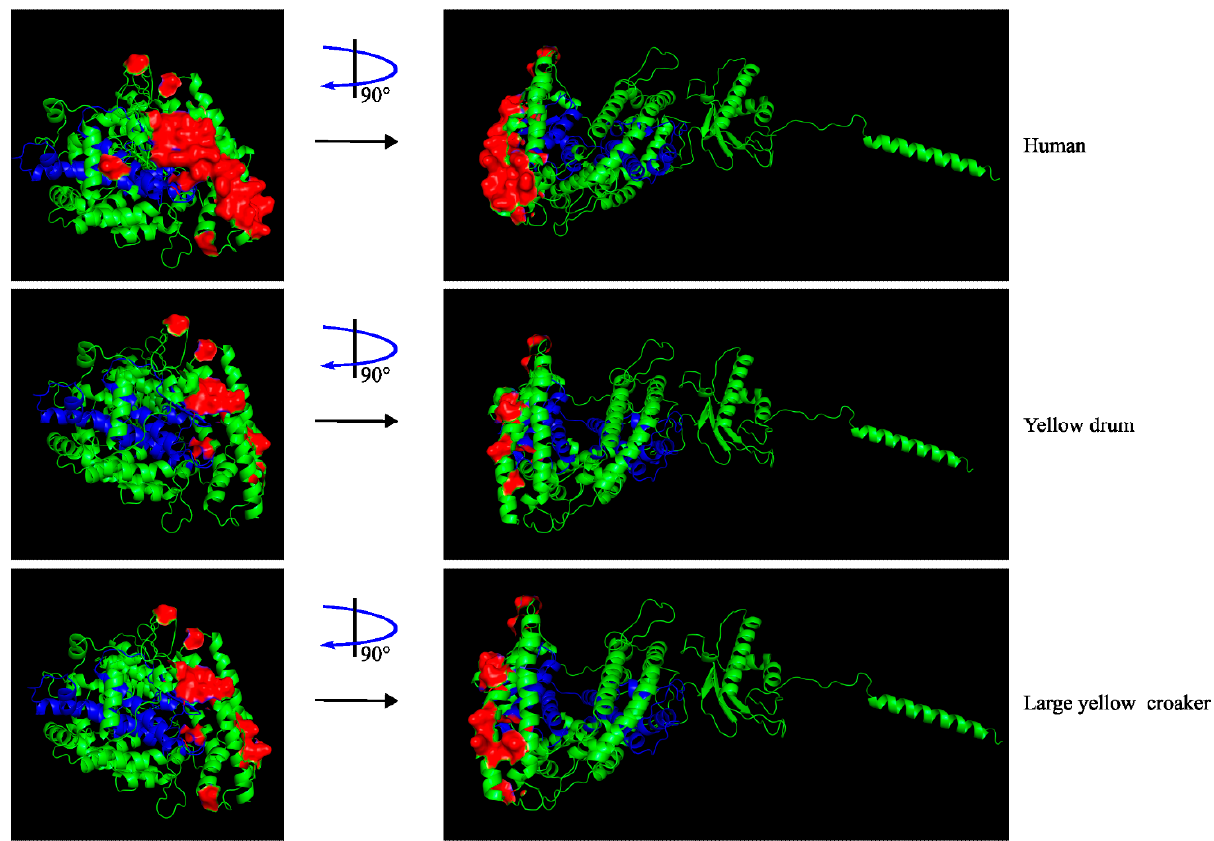
Figure 4. Three-dimensional structures of ACE2 protein in huamn (GenBank No. NP_S.1) and marine yellow drum (GenBank No. KAG8001285.1) and large yellow croaker fish (GenBank No. XP_010730146.1). The tertiary structure oSSf ACE2 protein were predicted with SWISS-MODEL workspace (swissmodel.expasy.org) and visualized by Visual Molecular Dynamics 1.9.4a51 and Pymol. Blue represents the active sites of ACE2 (346–517aa residues), and red represents the 25 spike-interacting key residues and their substitutes.